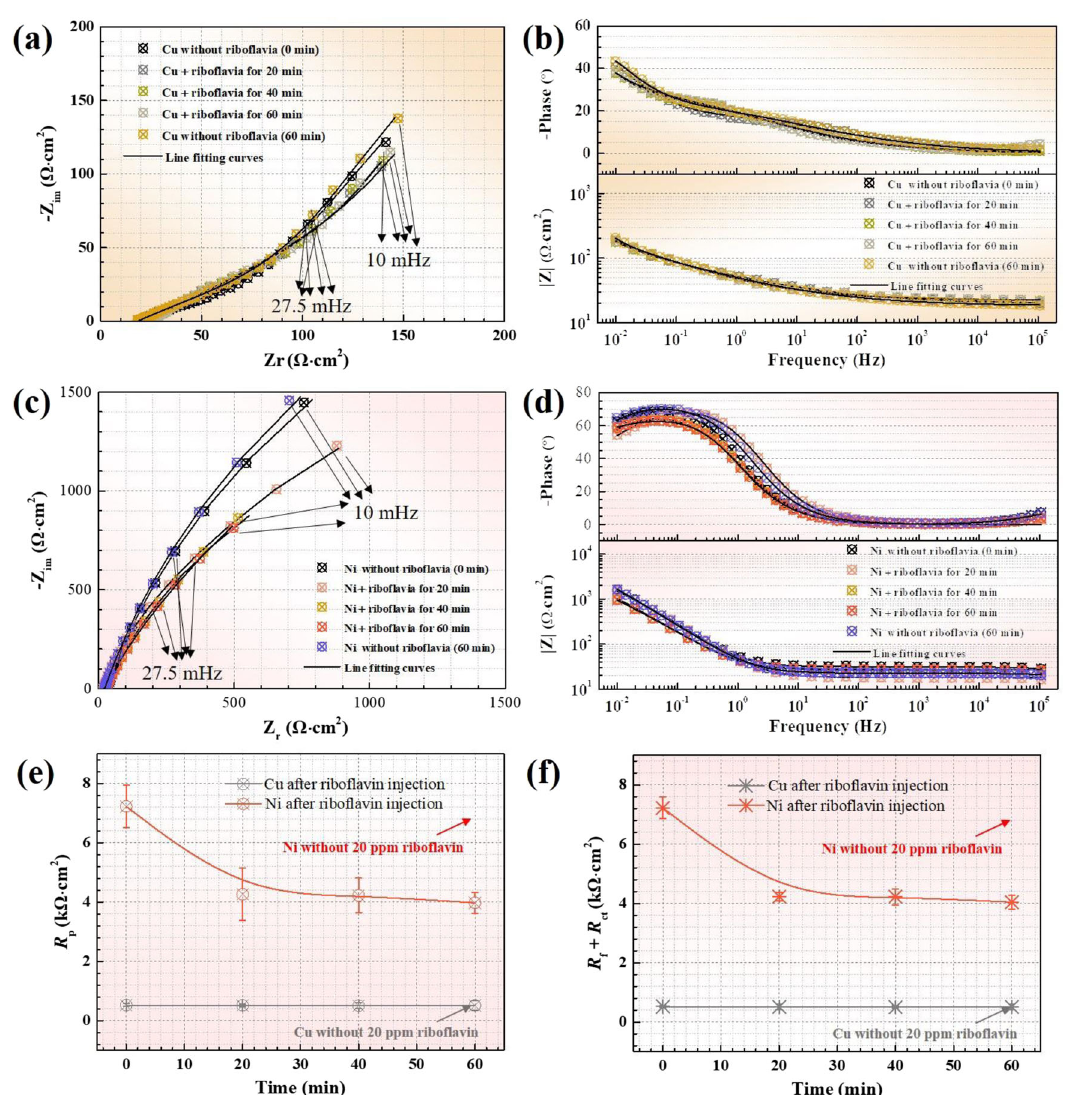
Fig. 13 Electrochemical responses of the D. vulgaris bio fi lm of 3-d pre-growth to ribo fl avin. Nyquist and Bode plots showing bio fi lm responses on Cu ( a , b ) and on Ni ( c , d ) coupons to injection of ribo fl avin, and the variations of R p ( e ), and R f + R ct from fi tted EIS parameters ( f ). (Error bars stand for the standard deviations from at least three independent